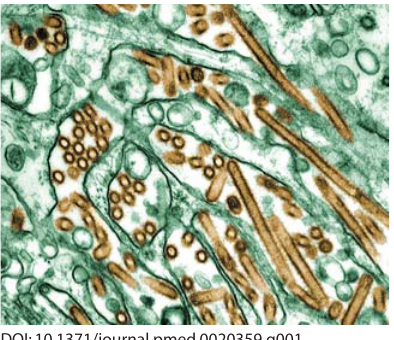
Figure 1. Colorized Transmission Electron Micrograph of Avian Infl uenza A H5N1 Viruses Grown in MDCK Cells The viruses are gold, and the MDCK cells are